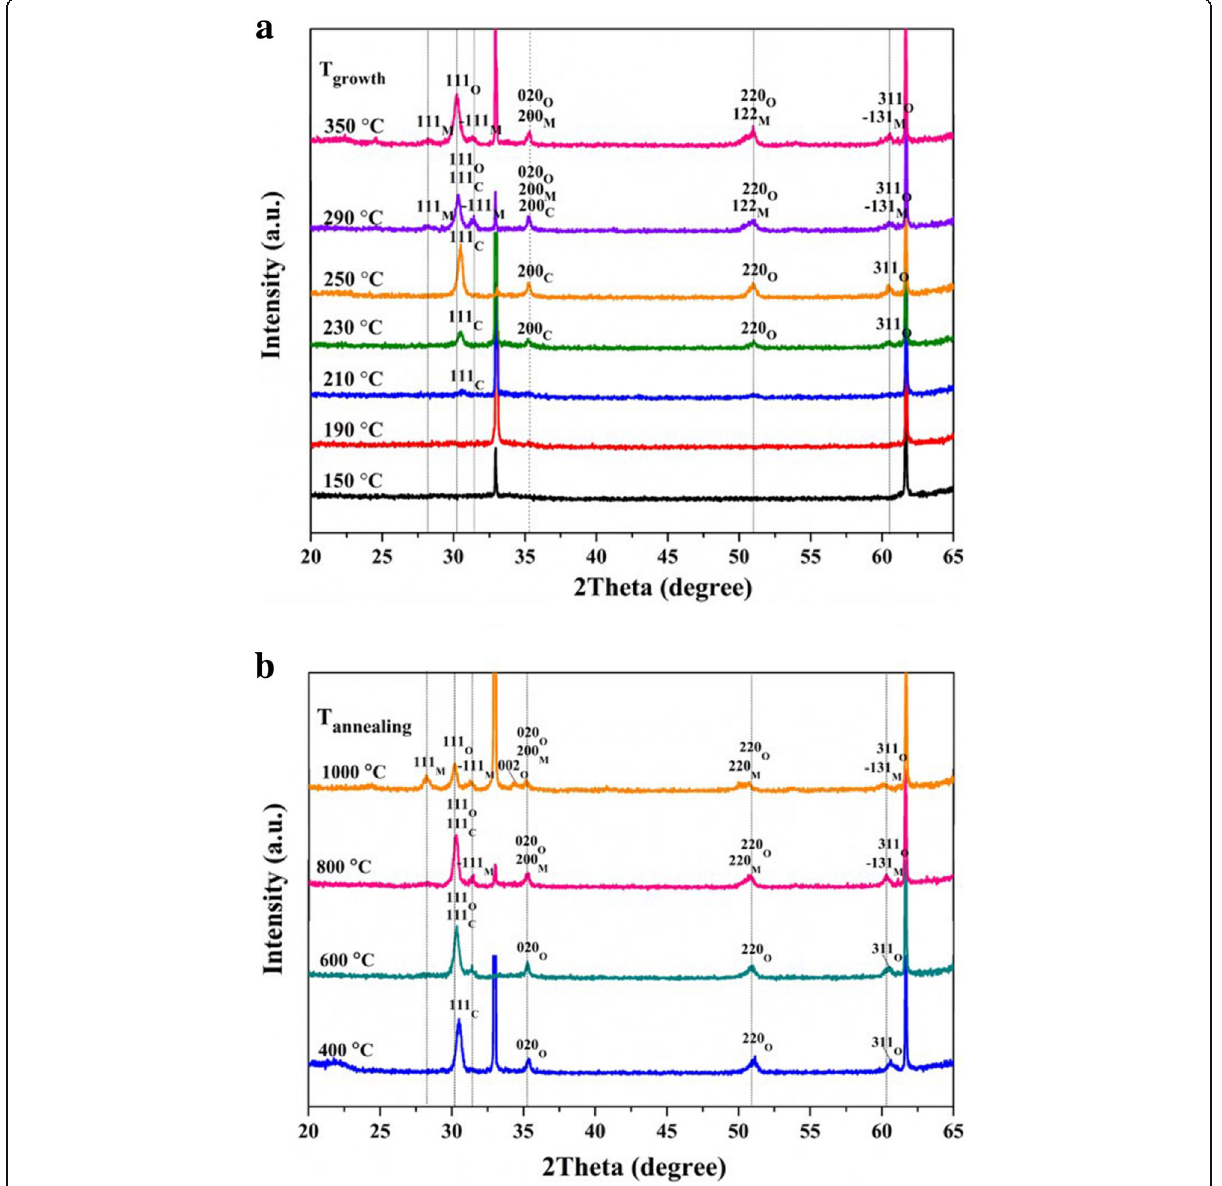
Fig. 3 The GAXRD patterns for ( a ) ZrO 2 films deposited at 150~350°C and ( b ) ZrO 2 films annealed at 400~1000 ℃ (deposited at